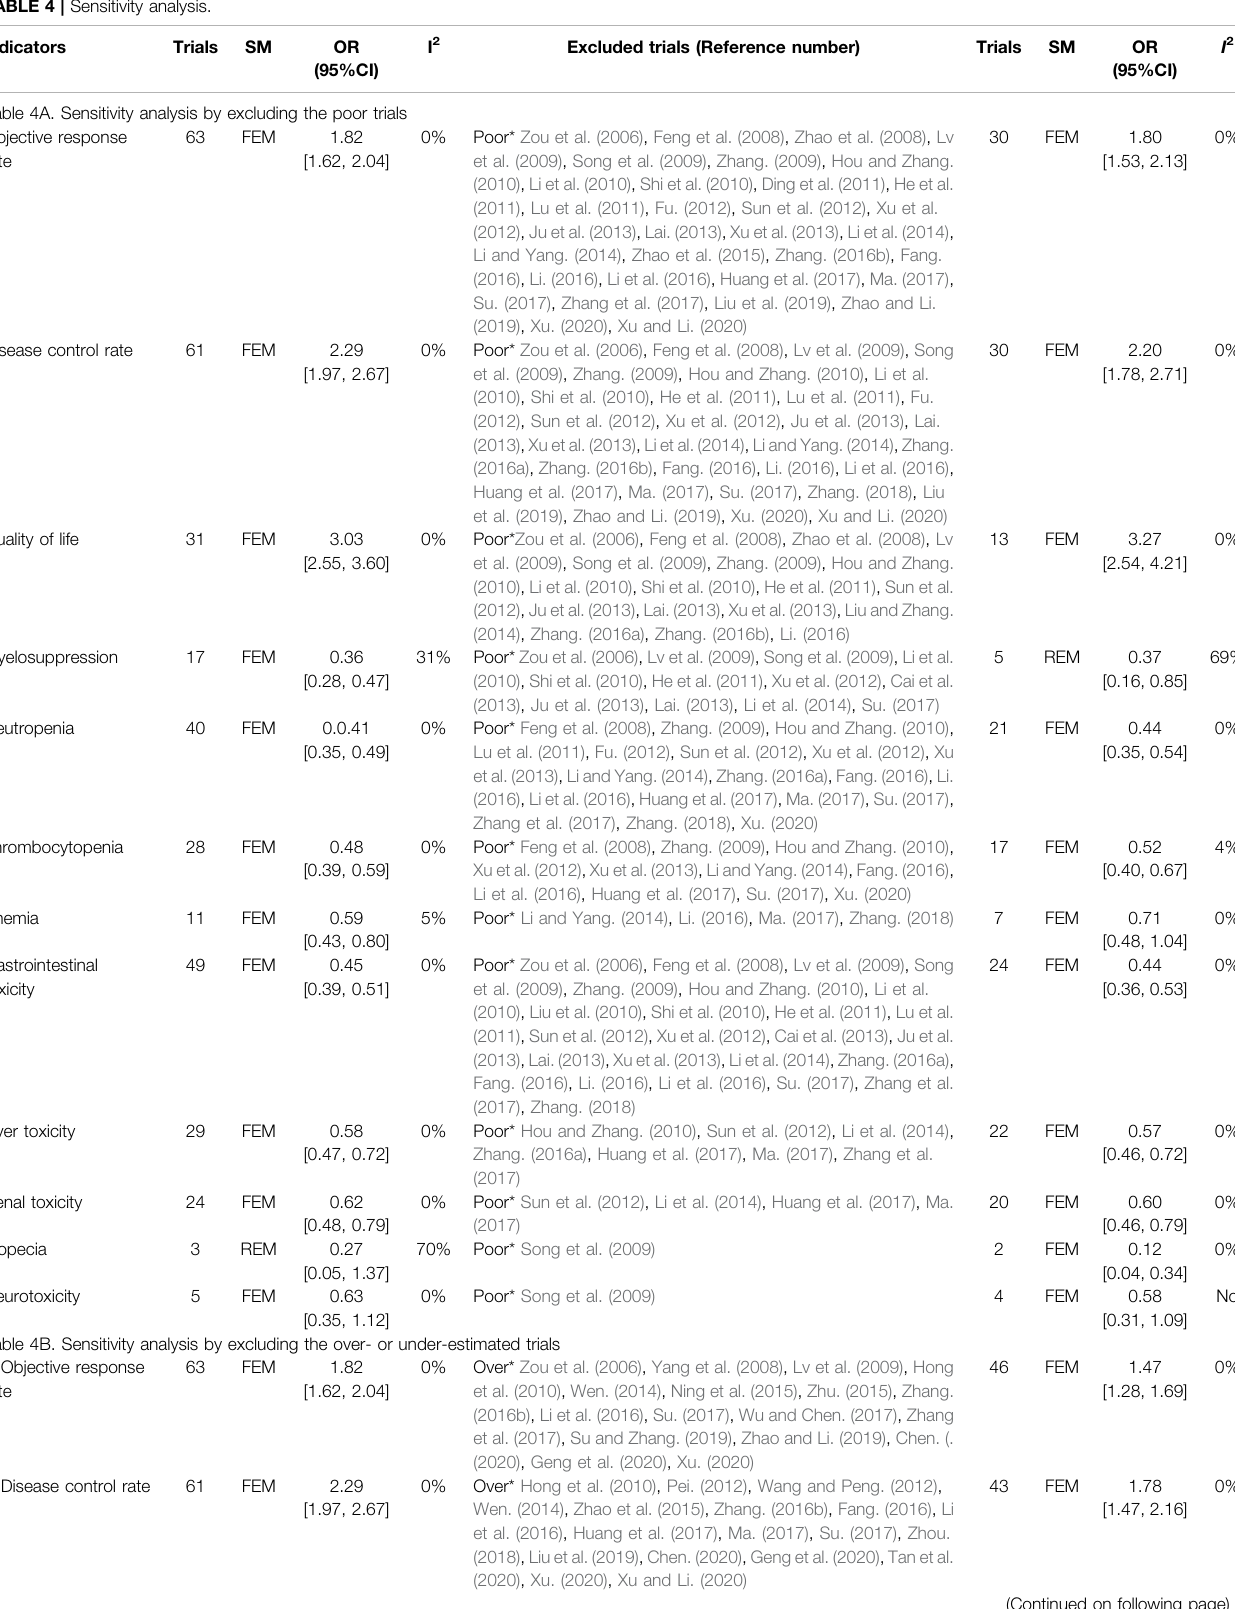
TABLE 4 | Sensitivity analysis.